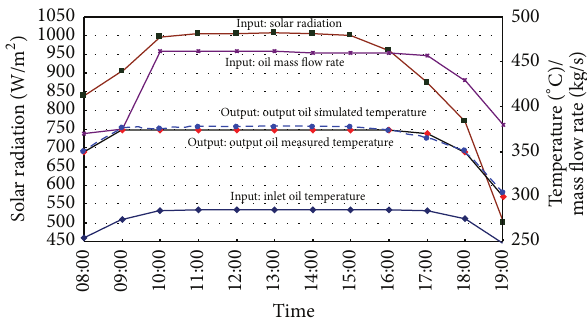
Figure 5: Comparison of simulated and measured results in spring working condition.